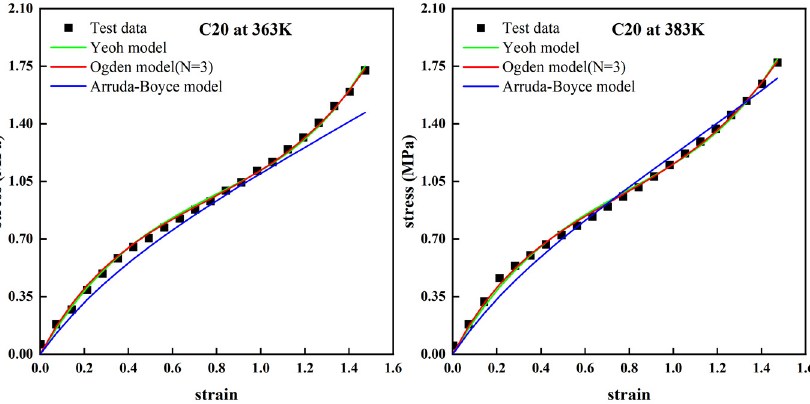
Figure 2. Fitting results of the Yeoh model, Ogden model ( N = 3), and Arruda–Boyce model for unidirectional stretching of the C20 rubber specimen at different temperatures.